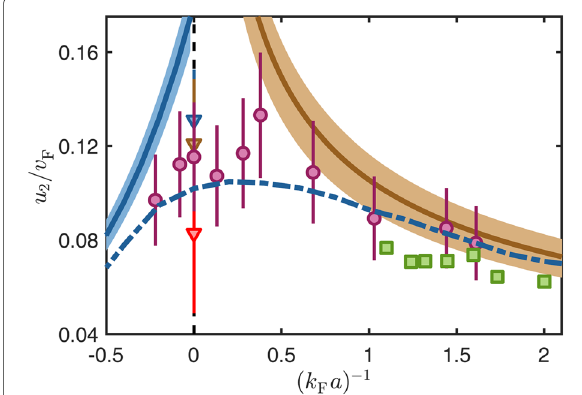
Fig. 12 The purple circles are the measured data from the Ulm experiment for temperatures in the range T / T c = 0.66 − 0.84. The brown and blue solid line show analytic predictions for the BEC and BCS regime at T = 0.75 T c , respectively. The blue dash-dotted line shows an earlier theoretical prediction of second sound at the crossover at T / T c = 0.75 [62]. The green squares are results of numerical c -field simulations. For comparison, the second sound velocities of a unitary Fermi gas measured by the Innsbruck group [23] at the temperatures T / T c = 0.65 (blue triangle), T / T c = 0.75 (brown triangle), and T / T c = 0.85 (red triangle) are also shown. From Ref.